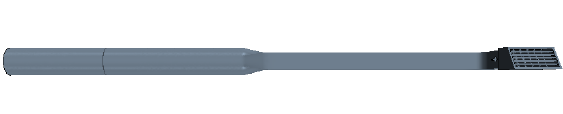
Fig. 3. The m odel geometry